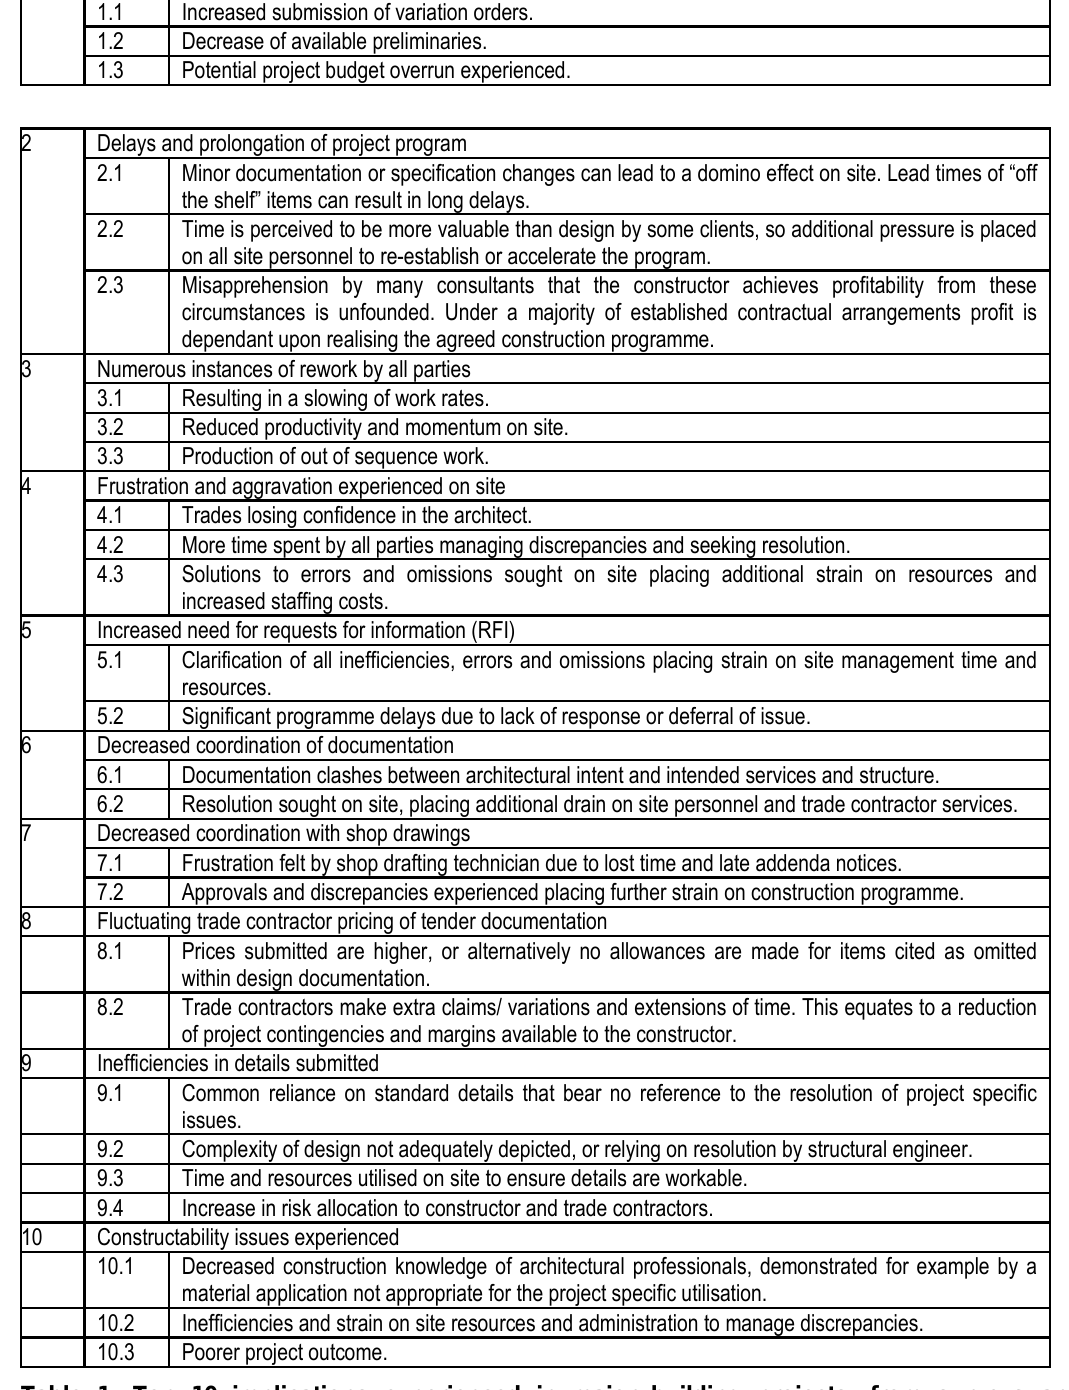
Table 1: Top 10 implications experienced in major building projects, from surveys and interviews of construction industry member carried out in this